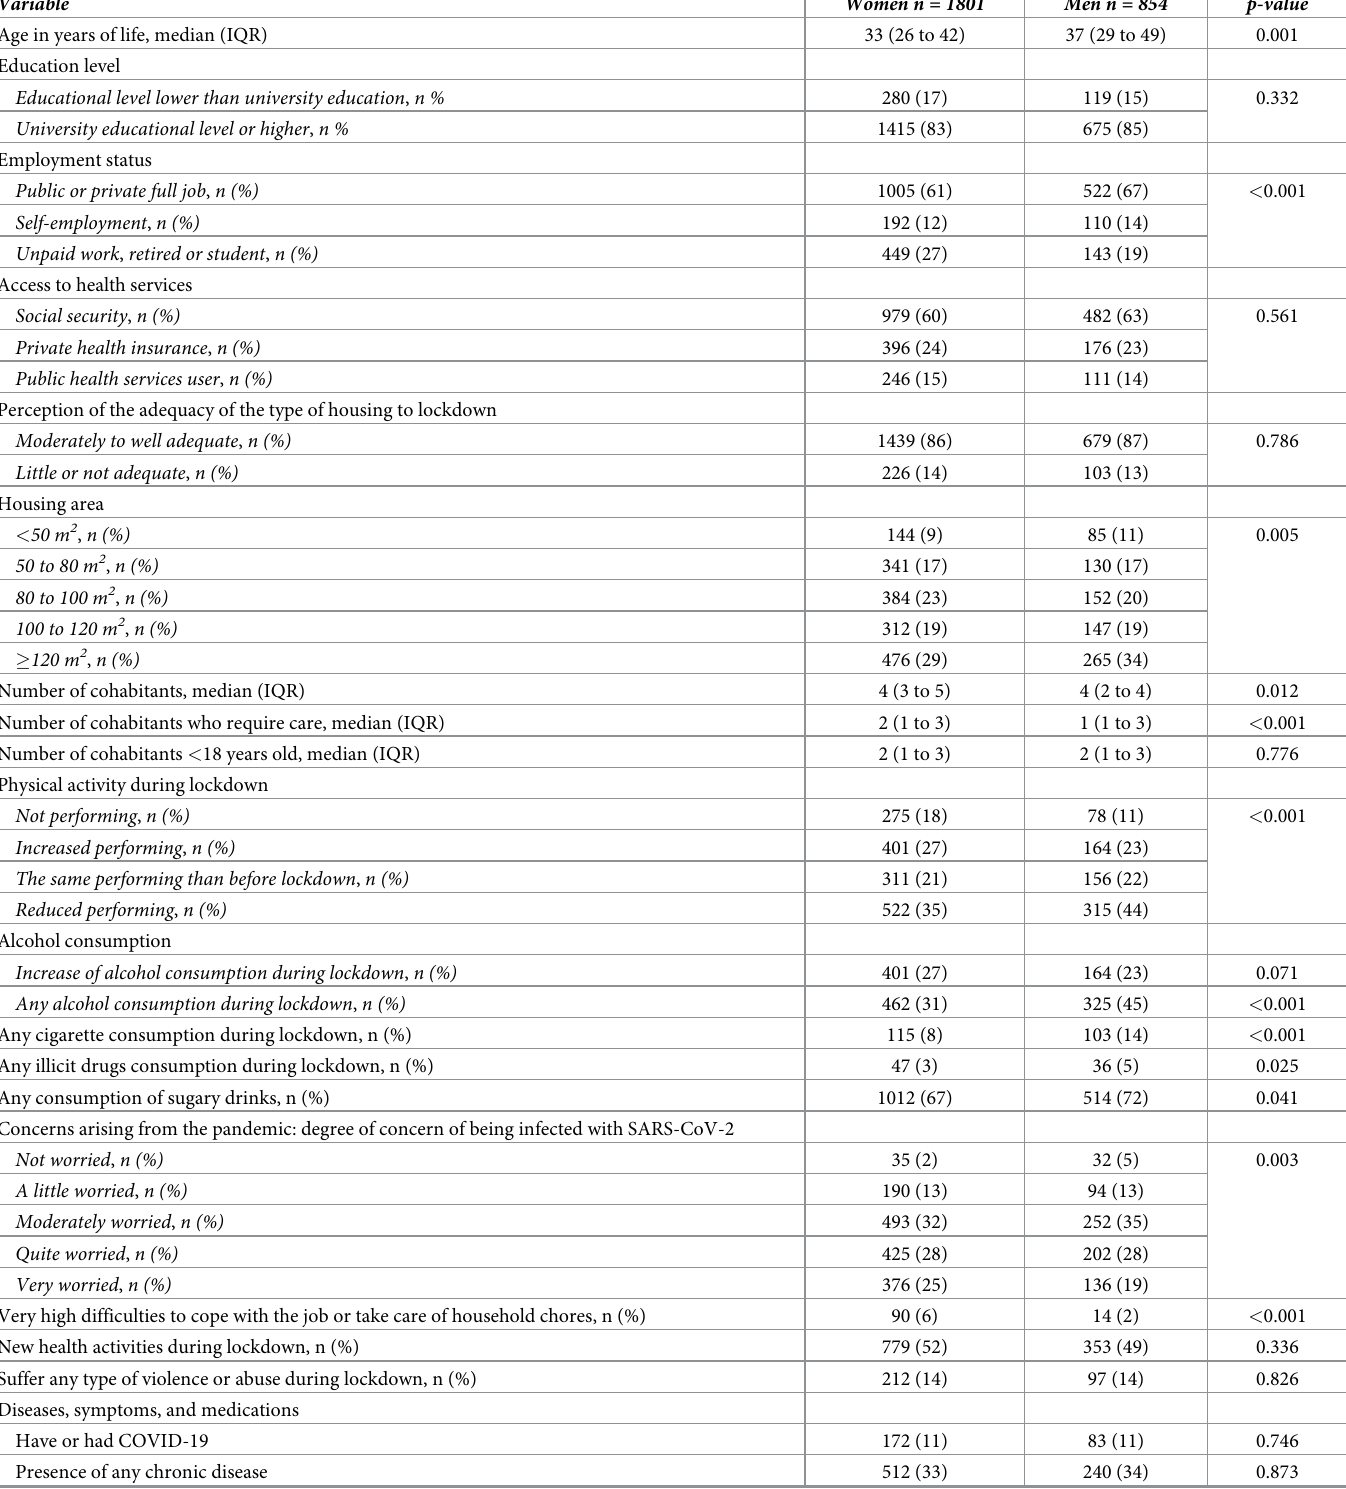
Table 2. Sociodemographic characteristics, social impact variables and mental health scale of participants by sex in Ecuador during lockdown (n =